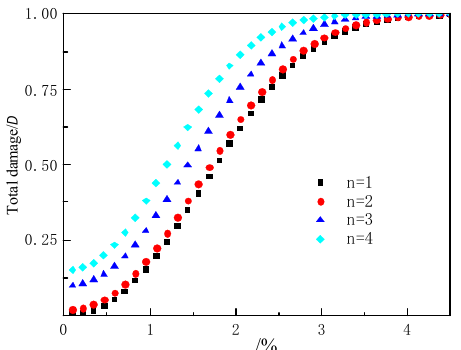
Figure 6. Total damage evolution curve of layered